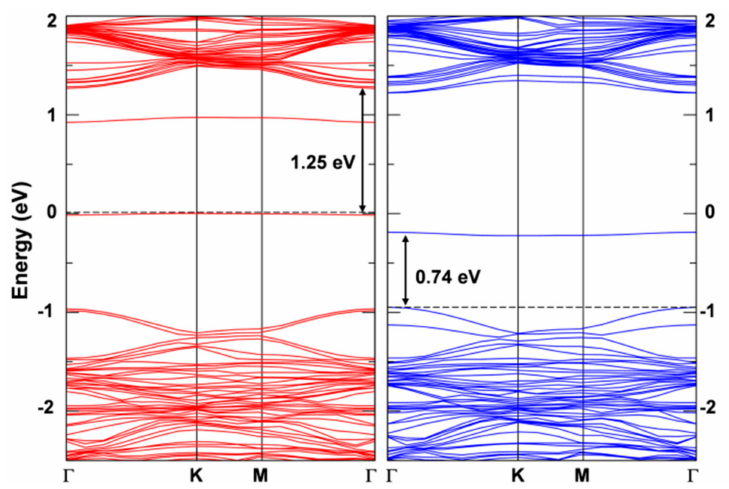
Figure 10. Band structure for the triplet state calculated by HSE06/CRY14 with a 6 × 6 supercell of WSe 2 . The red and blue lines represent the spin up and spin down bands, respectively. The black dashed line indicates the Fermi level and the Fermi level for spin up states is scaled to zero. Some energy difference is reported in eV.